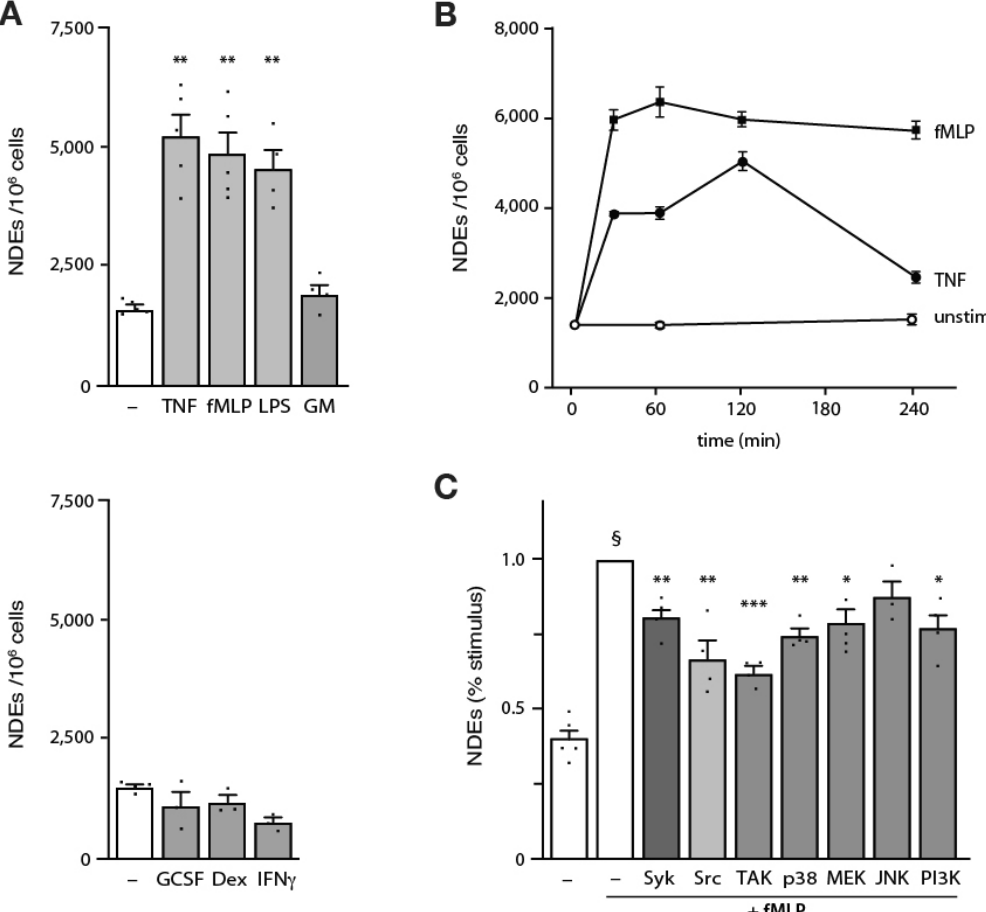
Figure 3. Induction of NDE generation and upstream signaling pathways. ( A ) Neutrophils were cultured for 30 min at 37°C in the absence (“–”) or presence of 100 nM fMLP, 100 U/mL TNFα, 100 ng/mL LPS, or 1 nM GM-CSF (upper panel); or 1000 U/mL G-CSF, 100 nM dexamethasone, or 100 U/mL IFNγ (lower panel). Culture supernatants were collected, and NDEs were isolated and counted as described in Methods . Mean ± s.e.m. from at least 3 independent experiments. ** p < 0.01 vs. unstimulated cells. ( B ) Neutrophils were cultured in the absence (“unstim”) or presence of 100 nM fMLP or 100 U/mL TNFα for the indicated times. Culture supernatants were collected, and NDEs were isolated and counted as described in Methods . The experiment depicted is representative of three. ( C ) Neutrophils were cultured (15 min, 37 °C) in the presence of the following signaling pathway inhibitors (or their diluent, 0.1% DMSO): piceatannol (10 µM) for Syk; Src-I1 (10 µM) for Src; 5Z-7-oxozeaenol (1 µM) for TAK1; SB203580 (1 µM) for p38 MAPK; UO126 (10 µM) for MEK; SP600125 (20 µM) for JNK; and LY294002 (10 µM) for PI3K. Cells were then further incubated in the absence (“–”) or presence of 100 nM fMLP for 120 min. Culture supernatants were collected, and NDEs were isolated and counted as described in Methods . Mean ± s.e.m. from at least 3 independent experiments. * p < 0.05; ** p < 0.01; *** p < 0.001; vs. stimulus alone. §, p < 0.01 vs. unstimulated